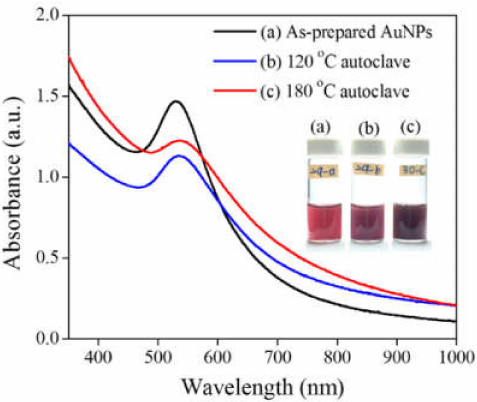
Figure 4. Absorption spectra of pectin-capped AuNPs before and after the hydrothermal process at di ff erent temperatures. Inserts are images of pectin-capped AuNPs under di ff erent conditions.